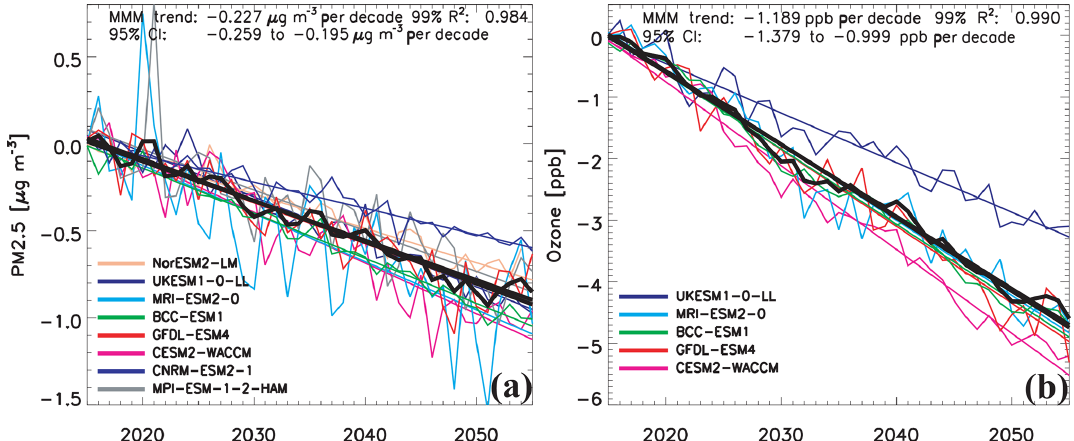
Figure 3. The 2015–2055 time series of global annual mean air pollution due to NTCF mitigation. Panels show (a) surface particulate matter (PM 2 . 5 ) (µgm − 3 ) and (b) surface ozone (ppb) for NTCF mitigation. The multi-model mean time series and the corresponding trend estimated using a weighted least-squares regression are included as thick black lines. The multi-model mean (MMM) trend, its significance, and R 2 value are also included, as is the 95% confidence interval (CI). Individual model mean trends are also included as defined by the legend.